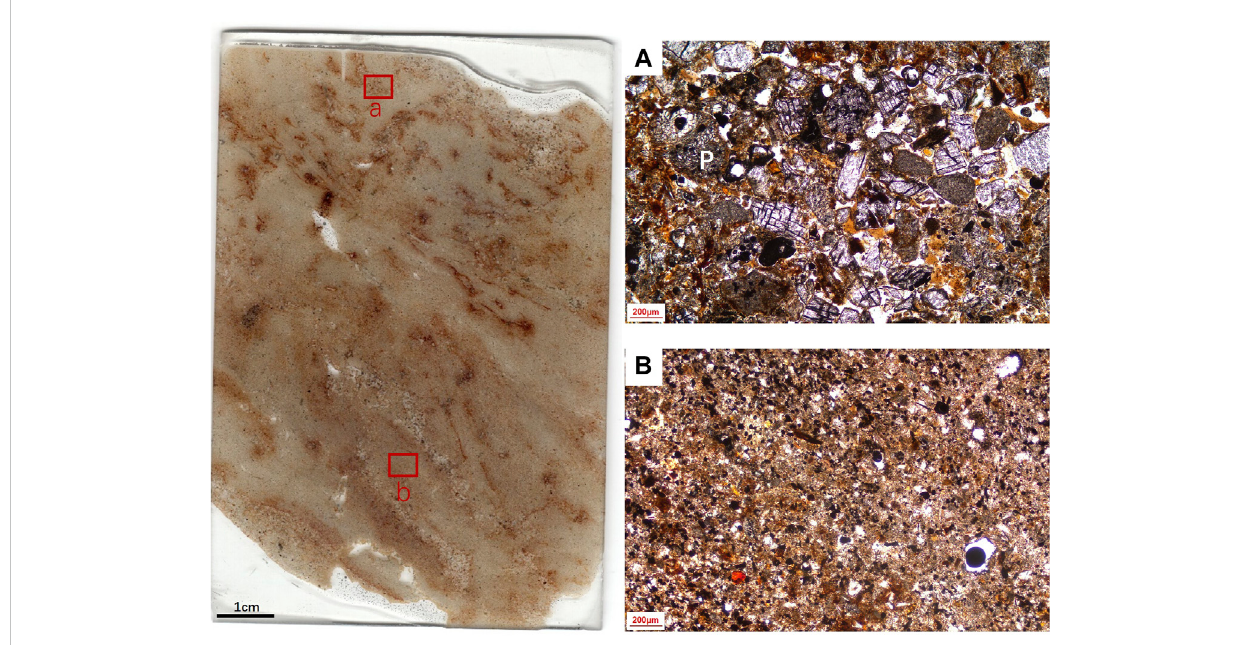
FIGURE 4 Scanofthethinsectionfrom blocksampleDD1.Abundantreddish-brownsesquioxidecanbeseen. (A) in fi llingsofwell-sorted fl uvialsands(PPL), P: pumice. (B) fi ne silty clay groundmass (PPL).